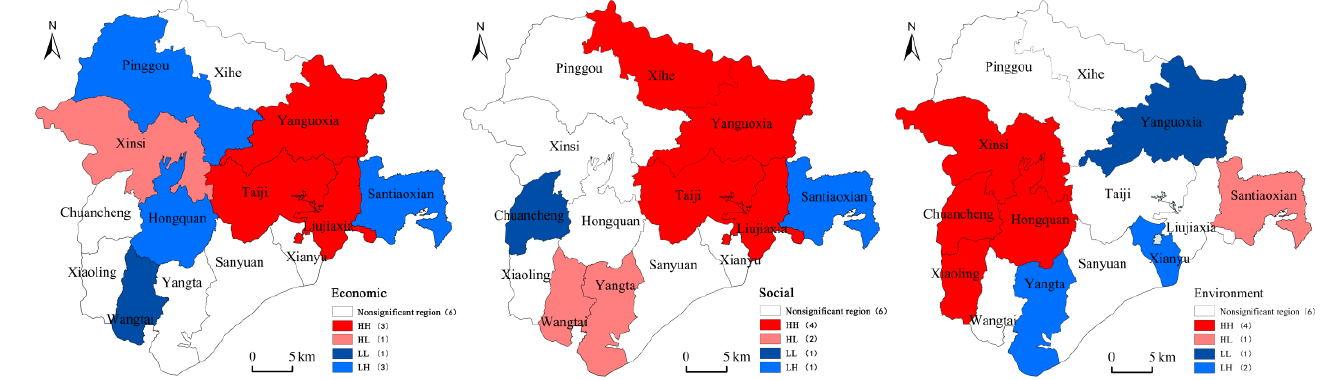
Figure 4. LISA significance distribution of sustainable livelihood in ecological migration area in Liujiaxia Reservoir area.